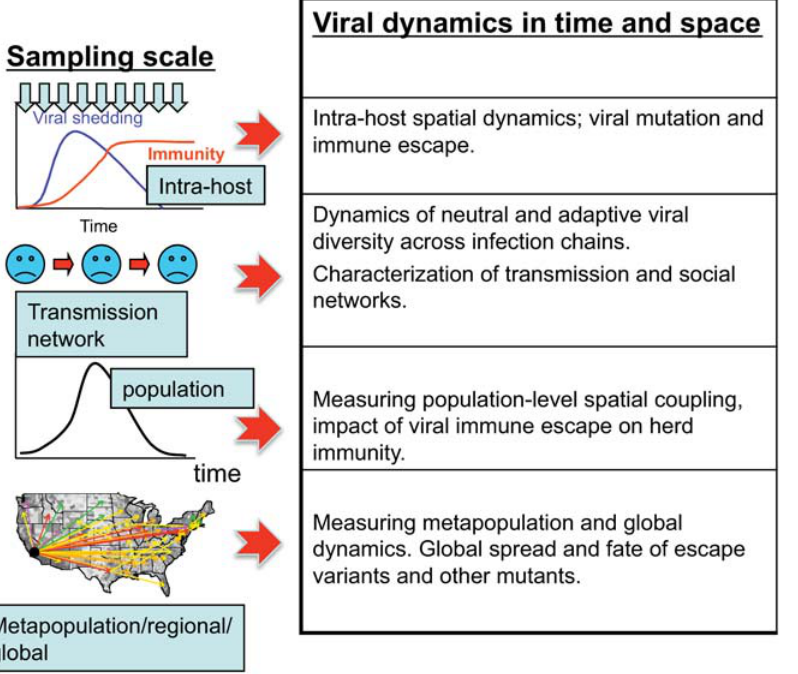
Figure 1. Sampling scales for acute RNA viruses and the associated phylodynamic processes that viral genome sequence data and host sampling can elucidate. doi:10.1371/journal.pcbi.1000505.g001 PLoS Computational Biology |